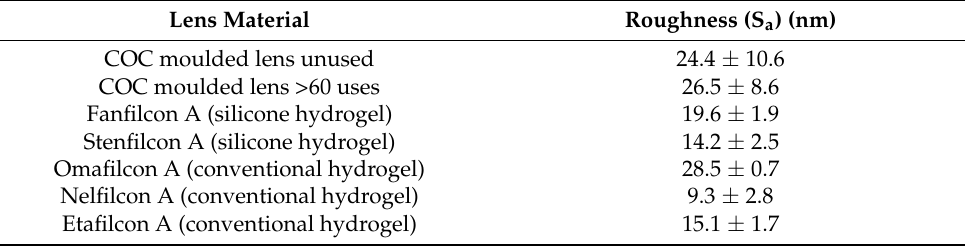
Figure 5. A soft contact lens produced from an unused COC mould ( A ) and a lens produced after significant mould use ( B ). The coloured legend indicates the height of the roughness in µ m. Table 2. White light interferometry surface roughness of COC moulded lenses and commercial